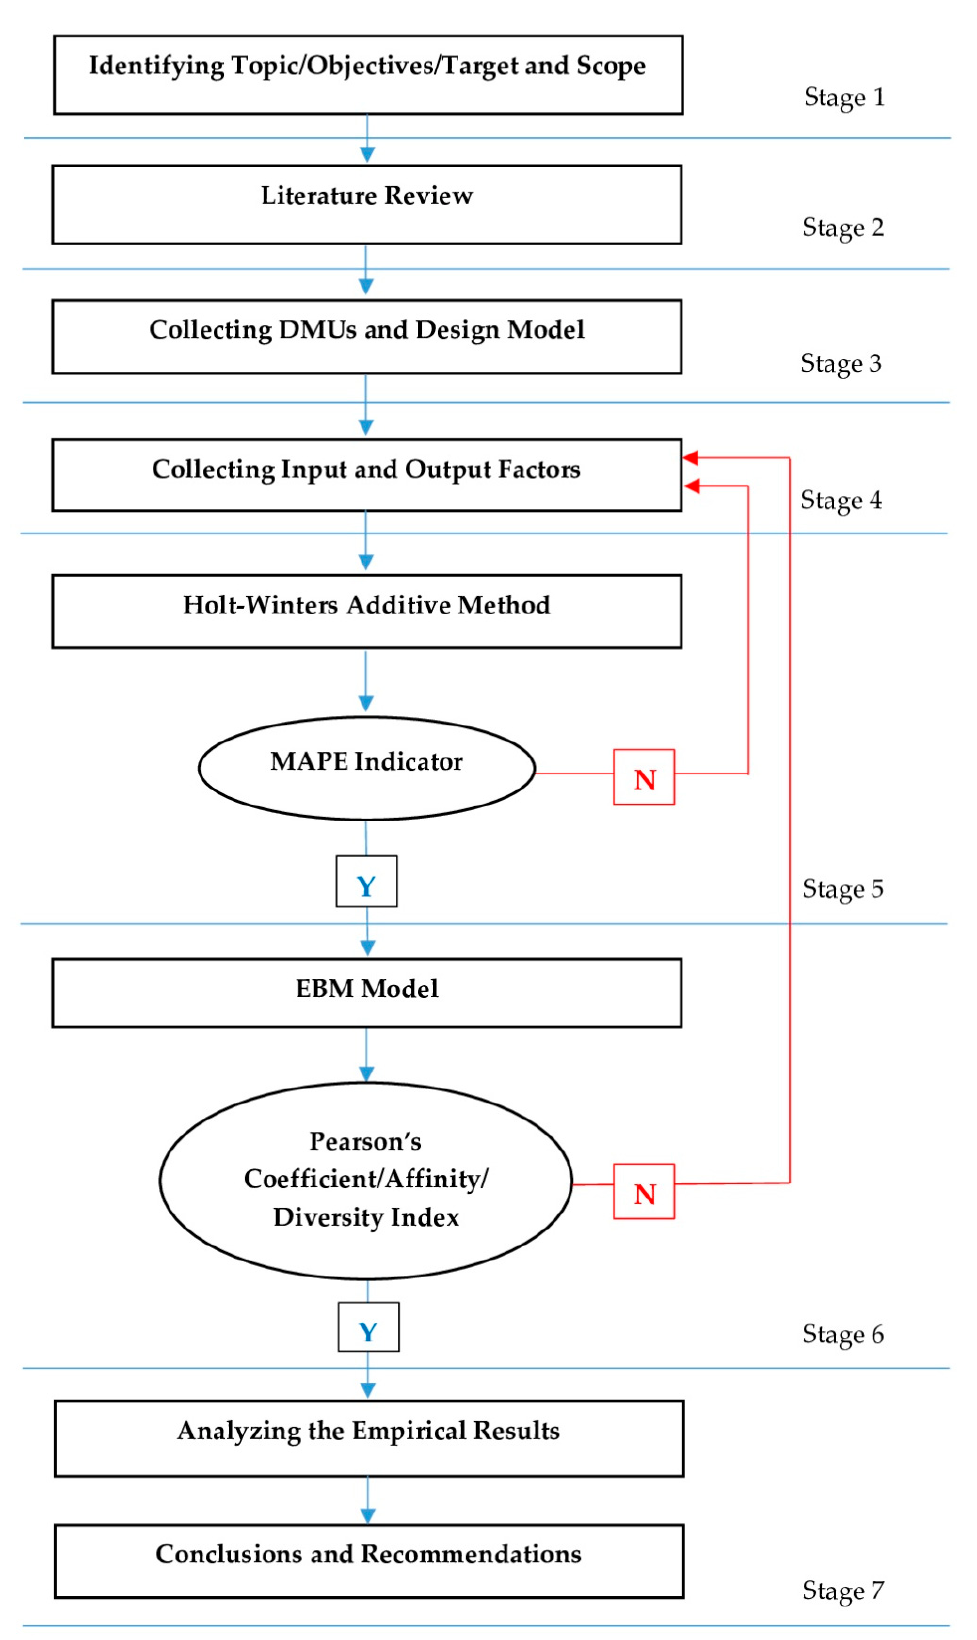
Figure 2. Research framework.